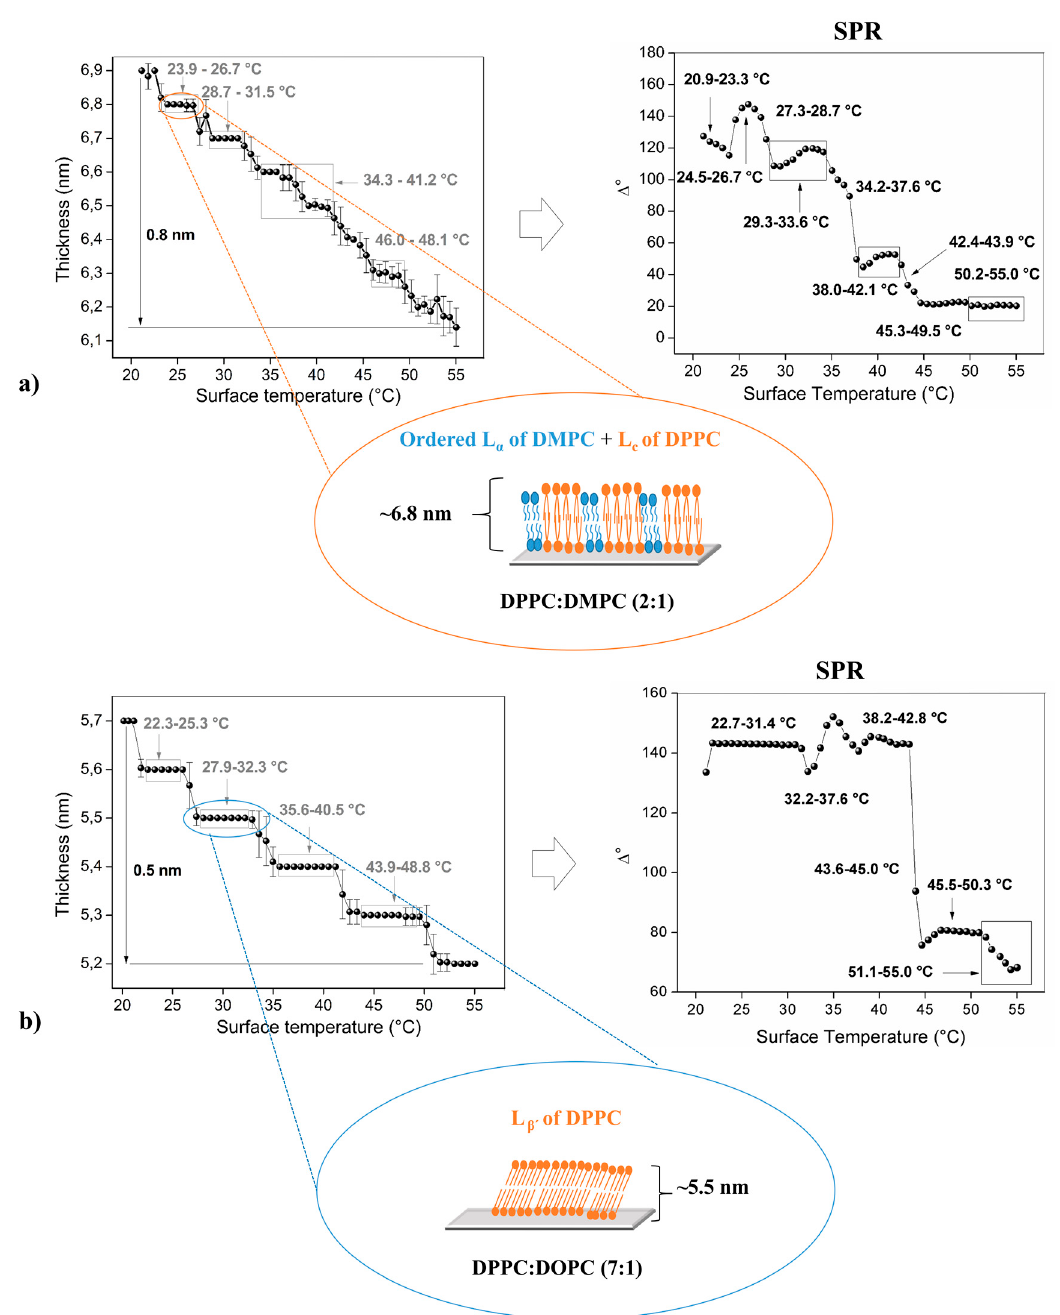
Figure 3. Thermal behavior detected by optical studies (ellipsometry and SPR) with their respective diagrams for ( a ) DPPC: 1,2-dimyristoyl- sn -glycero-3-phosphocholine (DMPC) (2:1) and ( b ) DPPC: 1,2-dioleoyl- sn -glycero-3-phosphocholine (DOPC) (7:1).